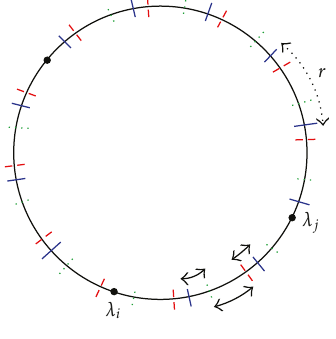
Figure 3: Sample plot of the zones on ∂Q determined by an arbitrary placement of three landmarks (under the geodesic distance). Note that the zones appear